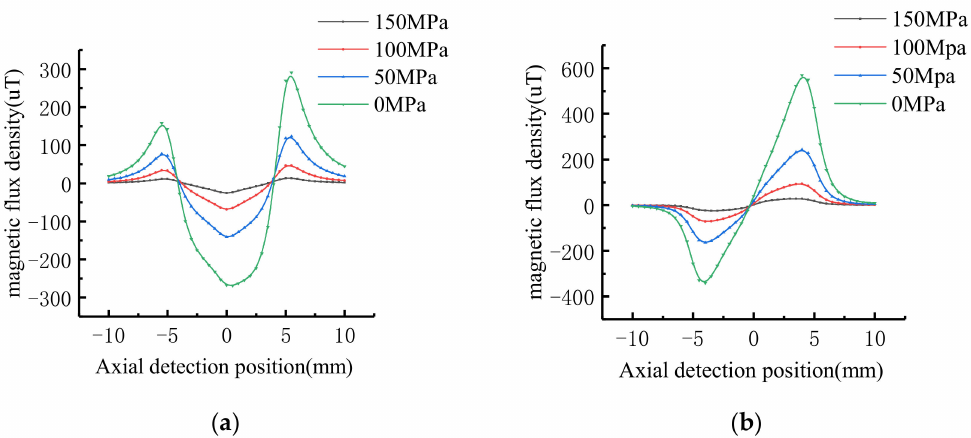
Figure 14. Signal characteristics of stress region with different stress gradient: ( a ) Tangential signal; ( b ) Normal signal. When the stress gradient is 40 MPa/mm, 30 MPa/mm, 20 MPa/mm and 10 MPa/mm respectively, the tangential signal amplitude is 311 µ T, 160 µ T, 75 µ T, and 28 µ T, respectively. The peak-to-peak values of normal signals is 832 µ T, 388 µ T, 163 µ T, and 52 µ T,